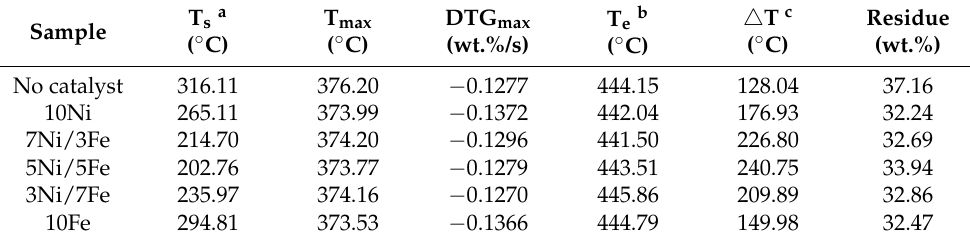
Table 2. Pyrolysis characteristic parameters for WT catalytic pyrolysis at 10 ◦